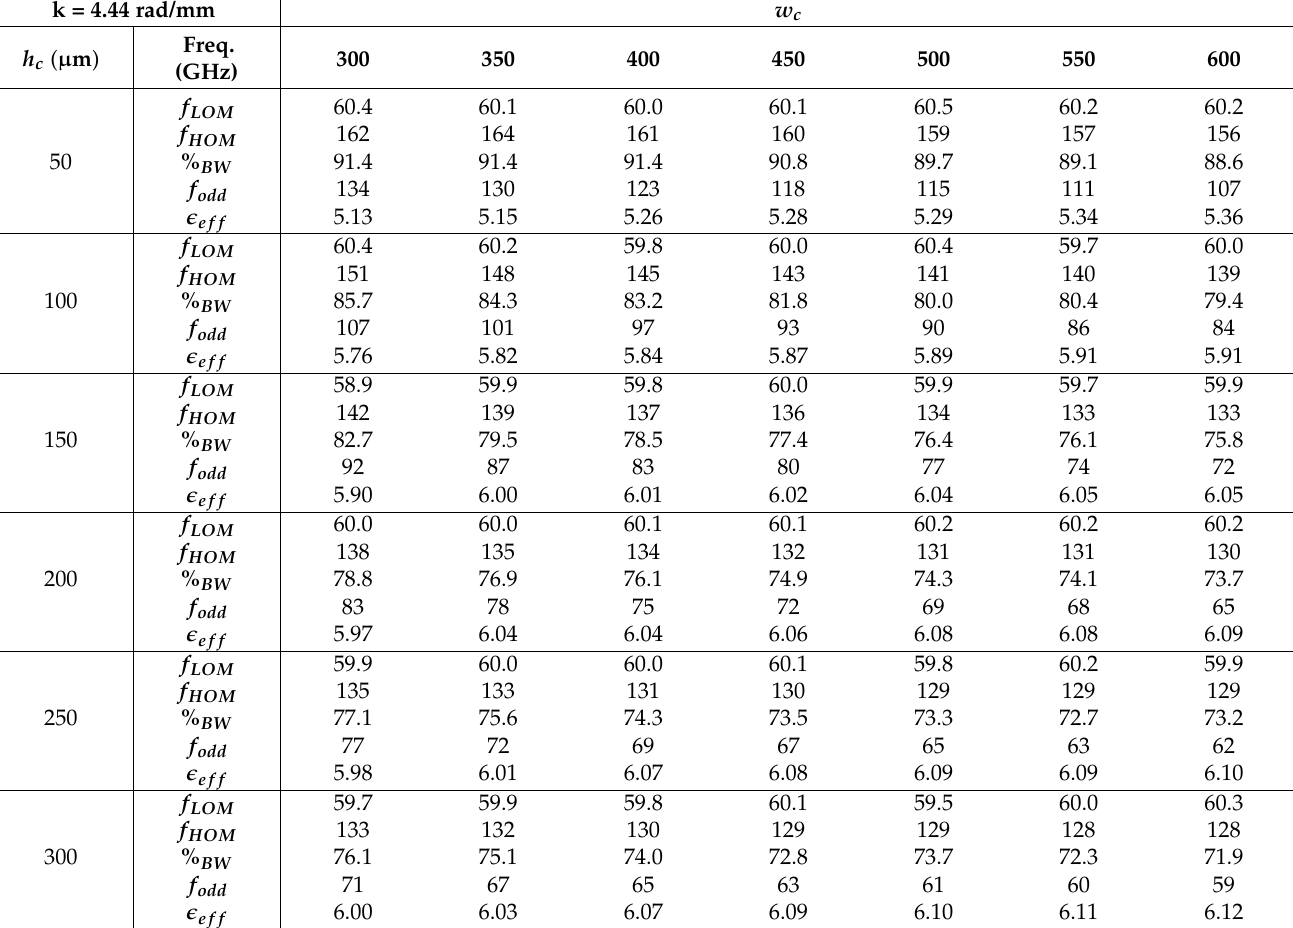
Table 2. Effect of the lateral ground extension in the operational bandwidth and odd mode cut-off. k = 4.44 rad/mm w